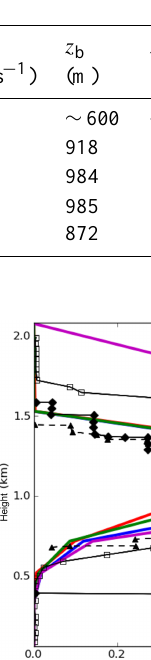
Table 3. As in Table 2, but for MPACE-B using the last 4 simulated hours. Observations are from K09.